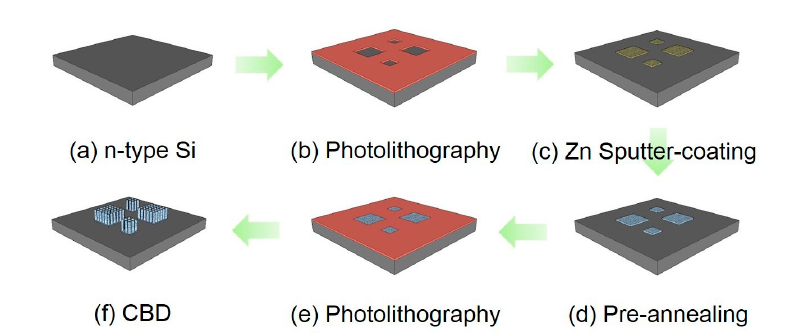
Figure 1. Schematic diagram of area-selective growth of aligned ZnO nanorods (NRs) on n -type